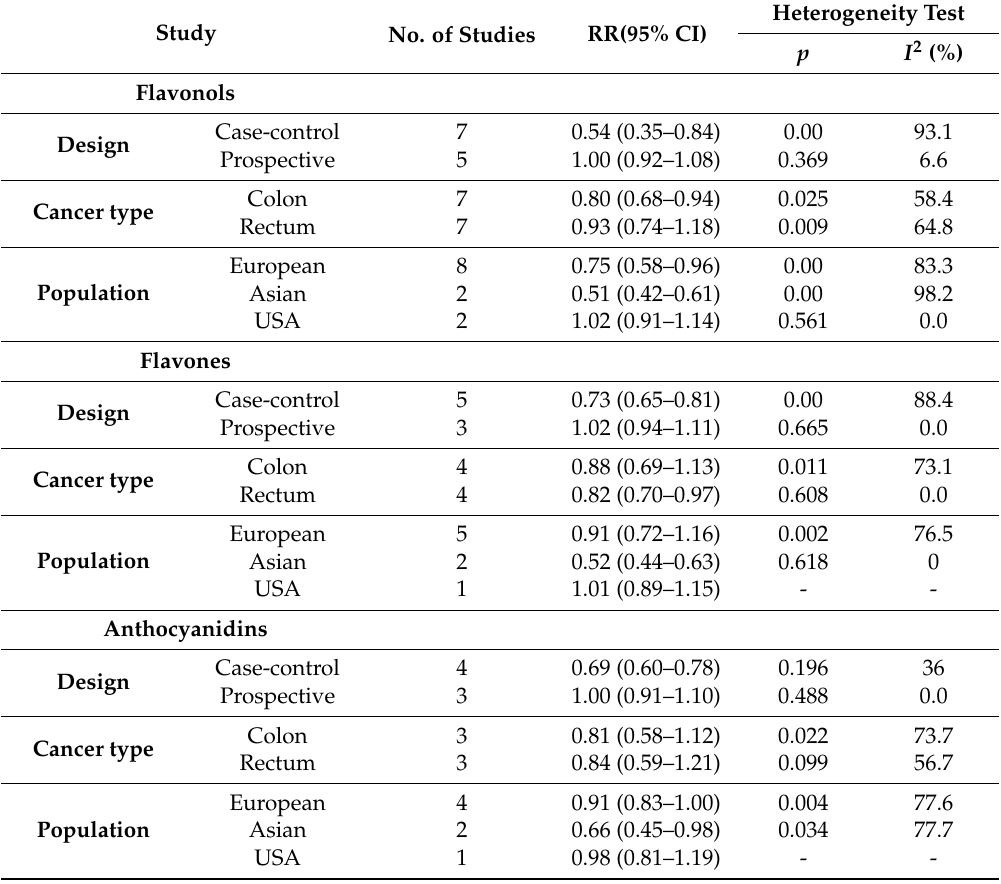
Table 2. Summary risk estimates for dietary flavonoids intake (highest vs. lowest) and colorectal cancer risk.